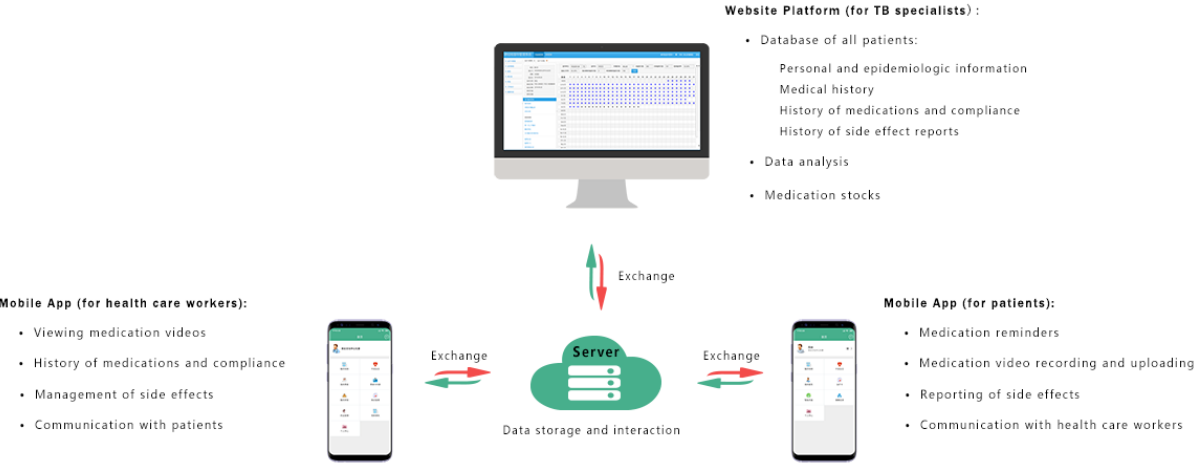
Figure 1. Schematic representation of the data collection and transmission on the comprehensive tuberculosis management system. TB: